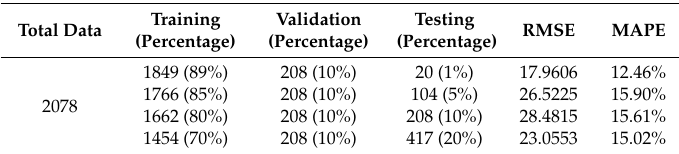
Table 10. Training, evaluation and testing dataset 1